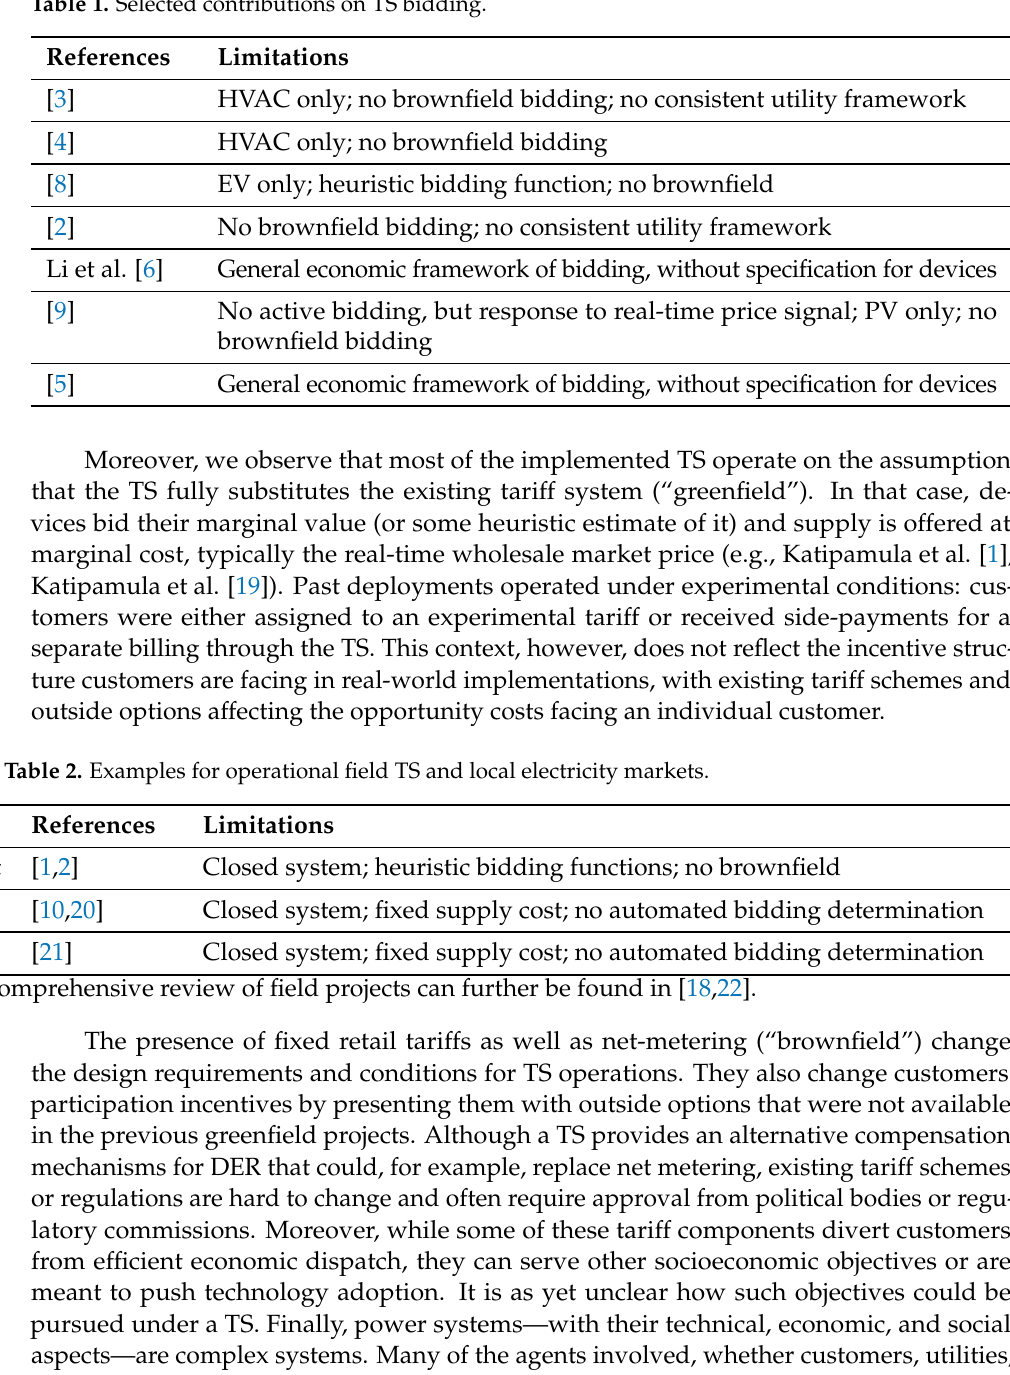
Table 1. Selected contributions on TS bidding.